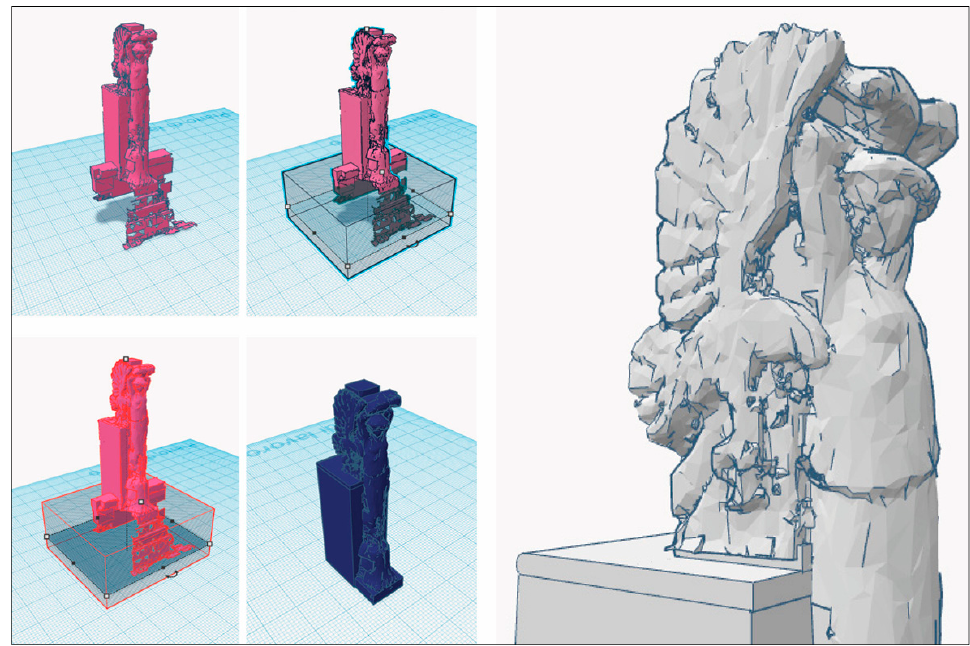
Figure 7. First modelling phase for 3D printing: the base of the statue, with